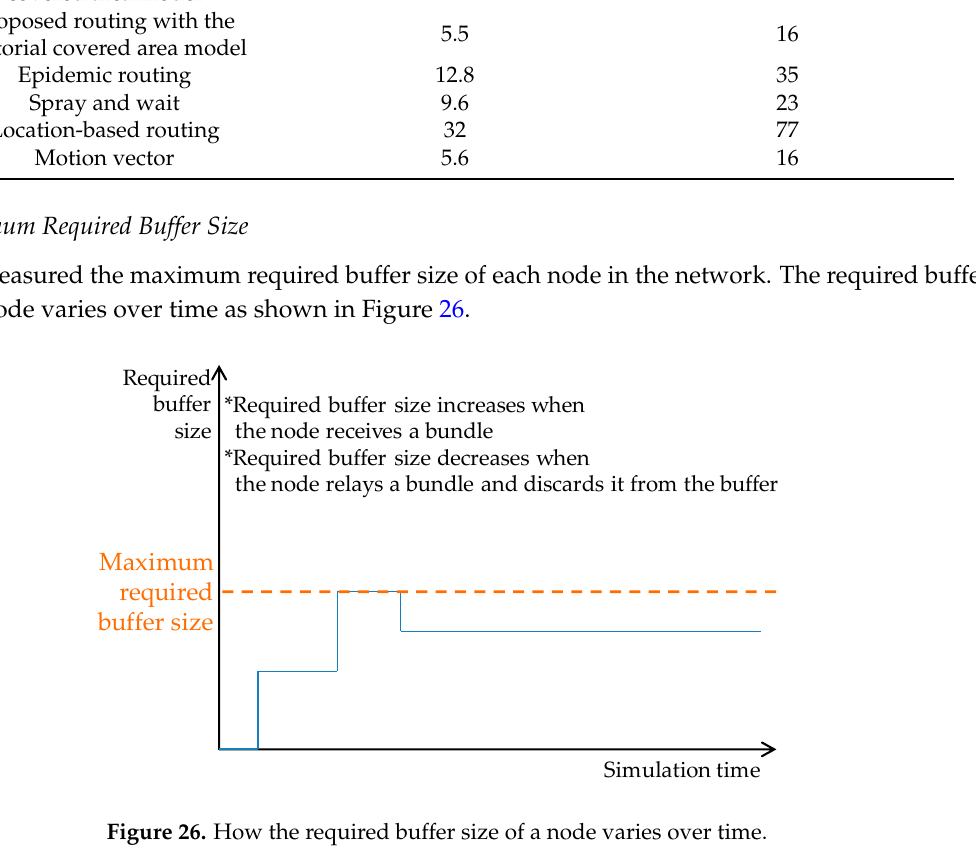
Figure 25. How to measure the number of hops.